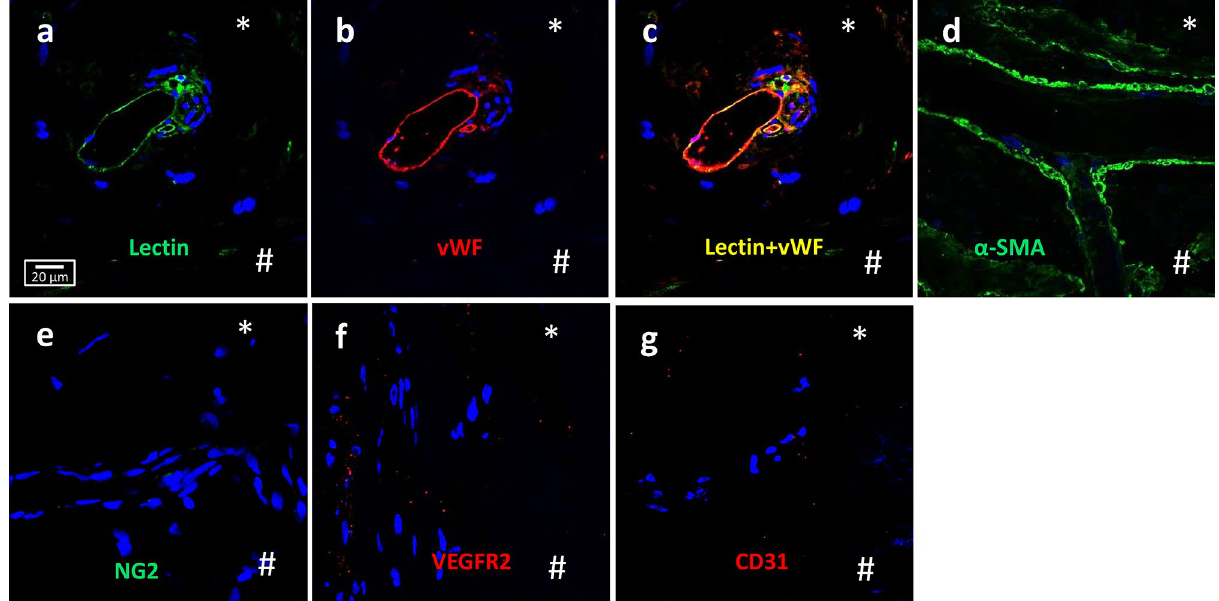
Figure 4. Phenotype characterization of micro-vessels in distal outflow region of human eyes. Representative images showing localization of lectin ( a ) and vWF ( b ) in micro-vessels found in paraffin sections of the distal outflow region (50–100 µm immediately downstream of outer wall of Schlemm’s canal and between the outer wall of Schlemm’s canal and episcleral region) of the conventional outflow pathway. When superimposed ( c ), the two molecules showed extensive co-localization in the endothelial cells of the micro-vessel. ( d ) Vessels from the distal outflow region were also positive for α-SMA but negative for NG2 ( e ), VEGFR2 ( f ) and CD31 ( g ). *Region of the section closest to the episcleral region; # area closest to the outer wall of Schlemm’s canal. Scale bar, 20